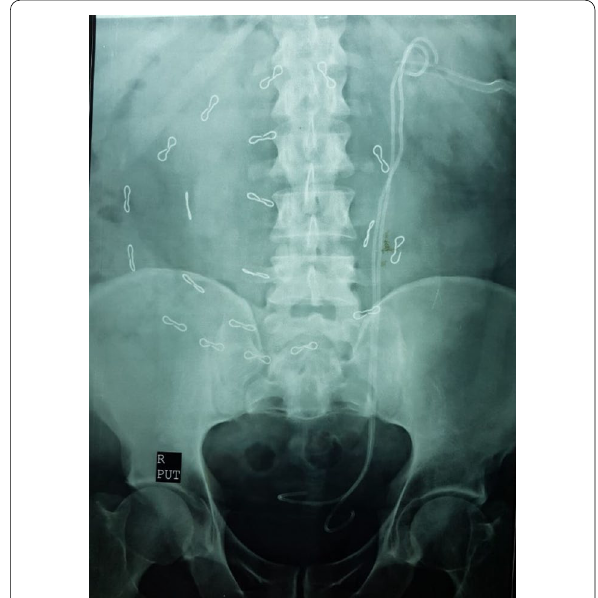
Fig. 3 Plain X-ray demonstrated clearance of renal and urinary bladder encrustations with left nephrostomy tube inserted